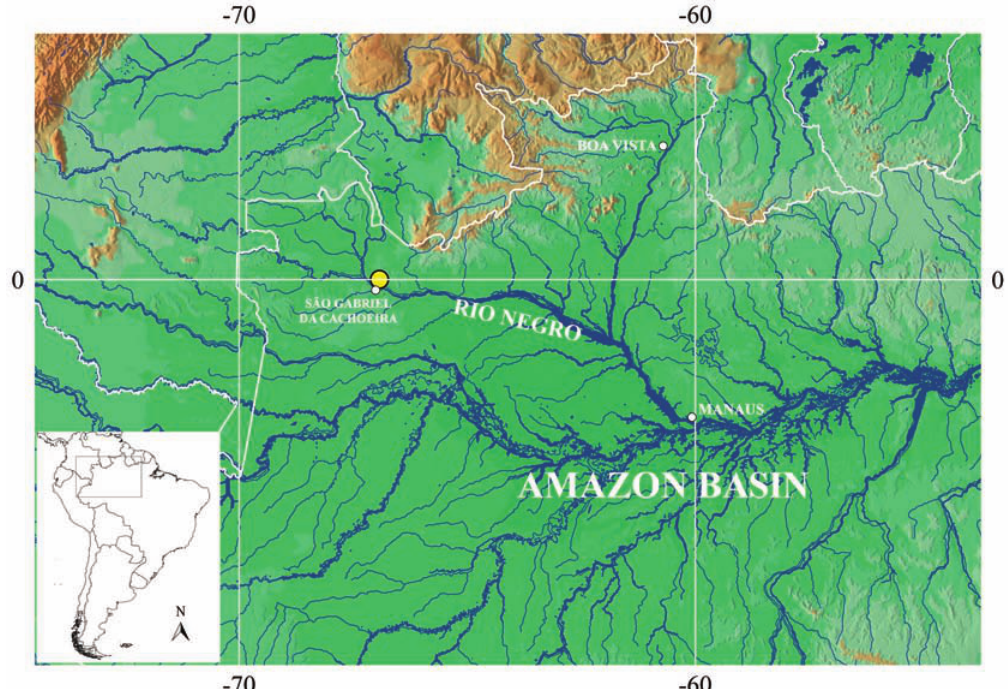
Fig. 2. Map of Western Amazon basin showing the collection locality of Cyphocharax sanctigabrielis (yellow dot) in the upper rio Negro near São Gabriel da Cachoeira, Amazonas,